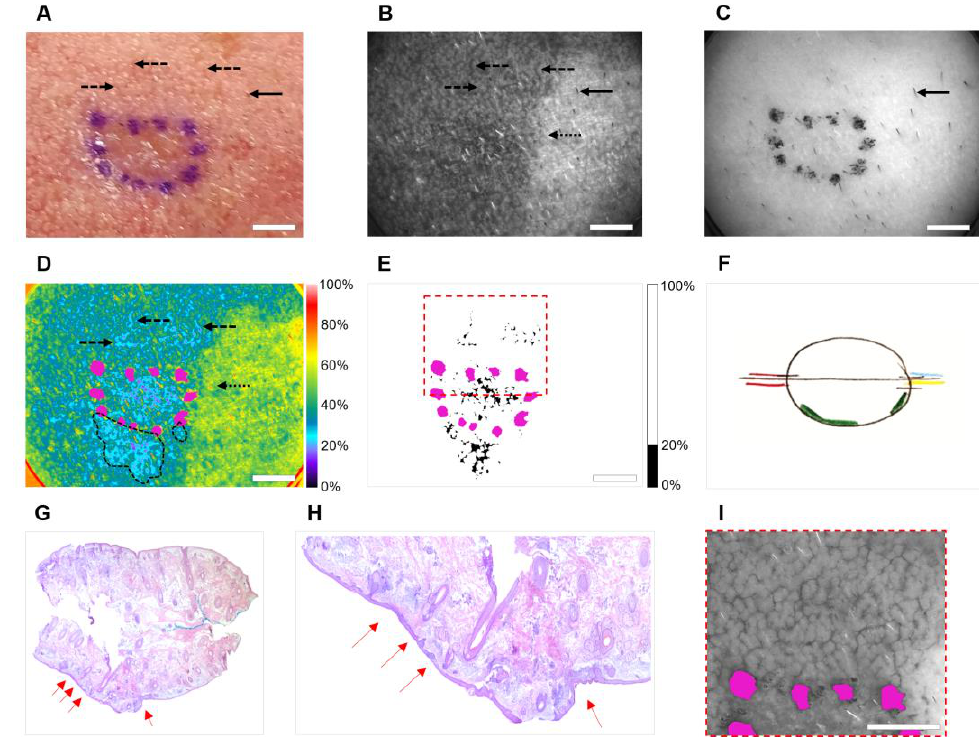
Figure 3. Case with false positive OPI margin assessment (subject #6). ( A ) Preoperative photograph of BCC lesion outlined with surgical marker; ( B ) 440 nm cross-polarized image; ( C ) 640 nm cross-polarized image; ( D ) Pseudo-colored, spectrally encoded image overlaid with surgical marker (shown in magenta). Positive margins have been outlined in dashed black lines. ( E ) Binary, spectrally encoded image overlaid with surgical marker (threshold = 20%); ( F ) Intraoperative Mohs map (positive margins are drawn in green); ( G ) H&E histology; ( H ) Magnified view of positive surgical margins in histology section; ( I ) Magnified view of region outlined by dashed red lines in ( E ) imaged at 570 nm. The color bars in ( D ) and ( E ) show pixel values as a percentage of the maximum pixel value in the image. Dashed black arrow: blood vessel; solid black arrow: hair follicle; dotted black arrow: nonuniform illumination; solid red arrow: residual tumor at lateral boundary of H&E section. Scale Bar = 5 mm.